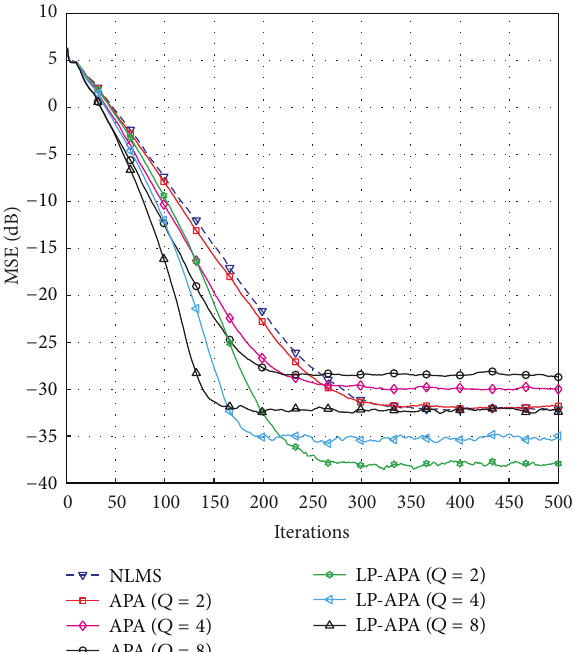
Figure 3: Effects of 𝑝 on the proposed LP-APA.